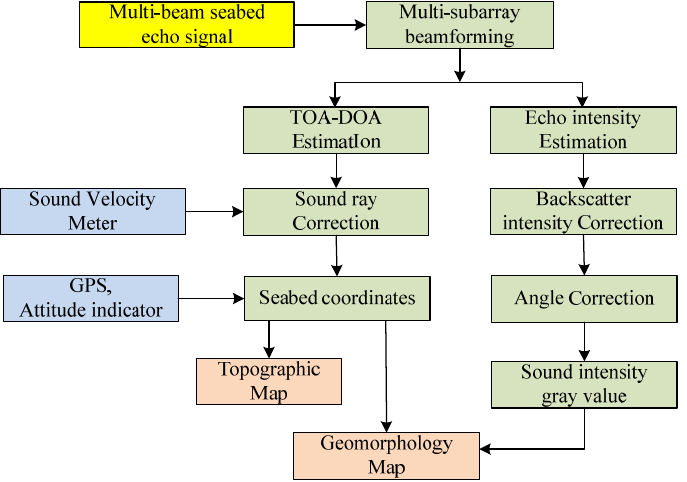
Figure 7. Flowchart of seabed topography and sediments imaging for multibeam detection sonar.